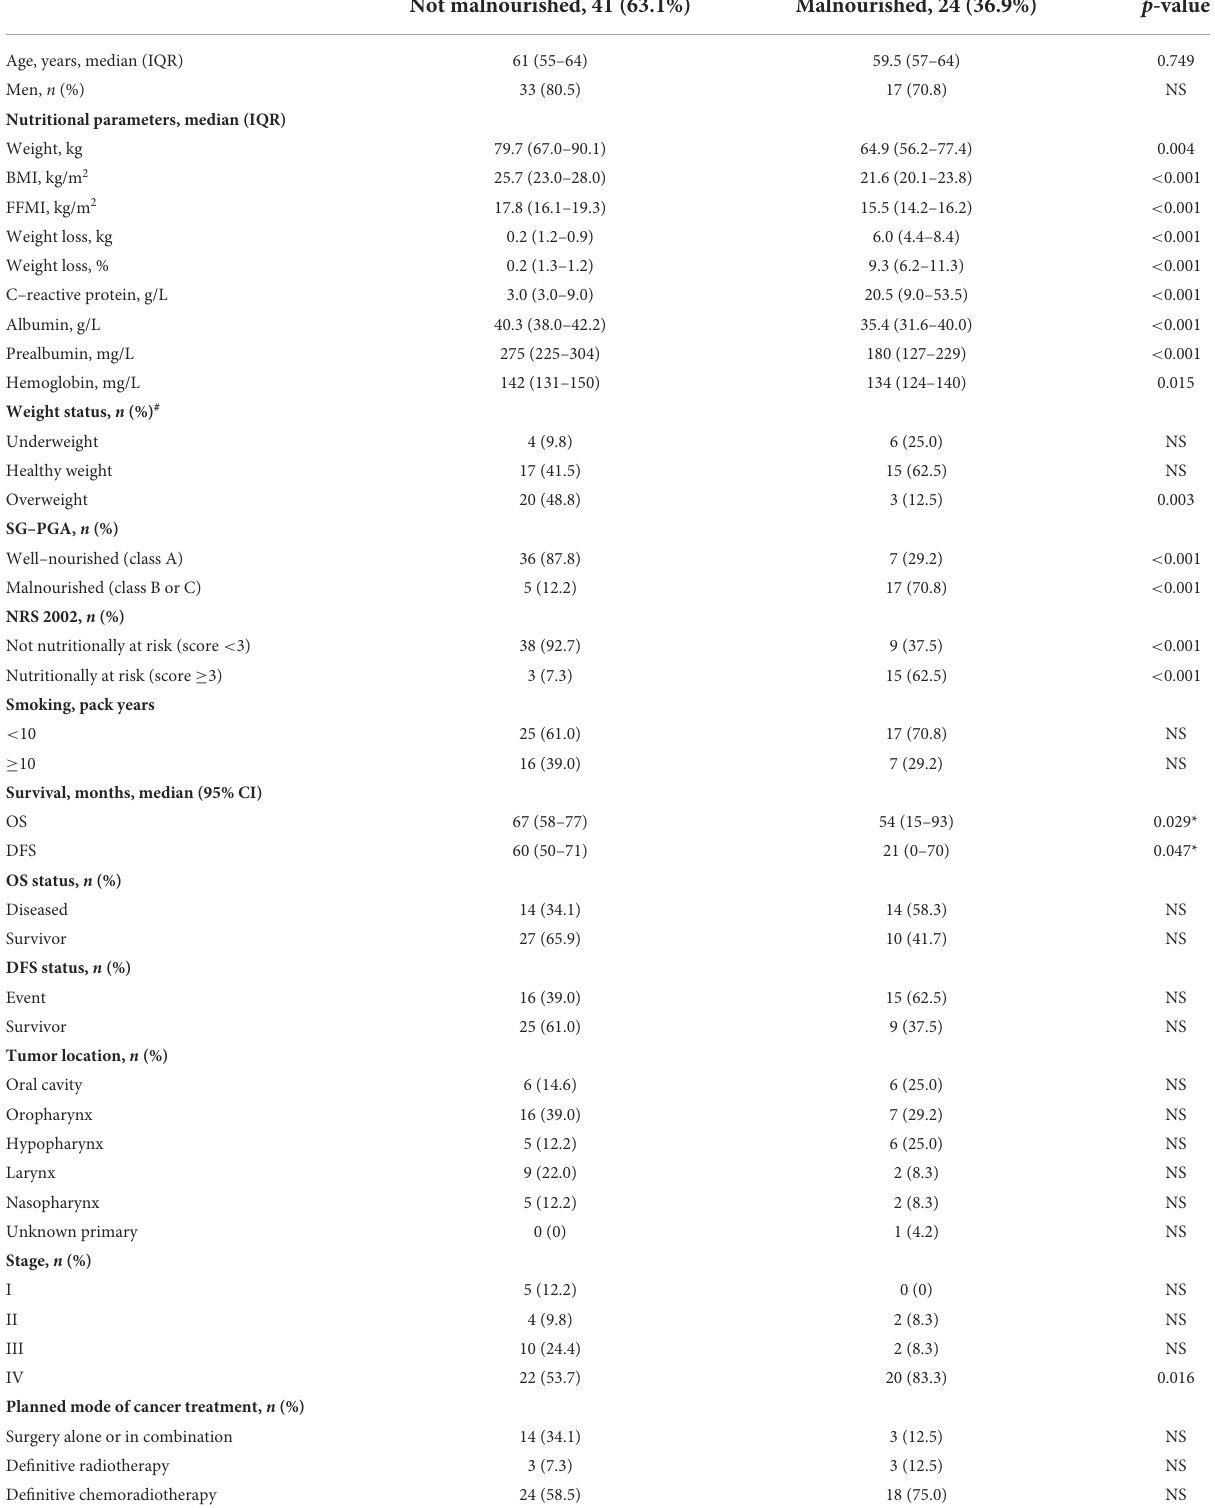
TABLE 1 Descriptive data of 65 HNC patients stratified according to GLIM-defined malnutrition diagnosis. GLIM-defined malnutrition diagnosis ( n = 65) Not malnourished, 41 (63.1%) Malnourished, 24